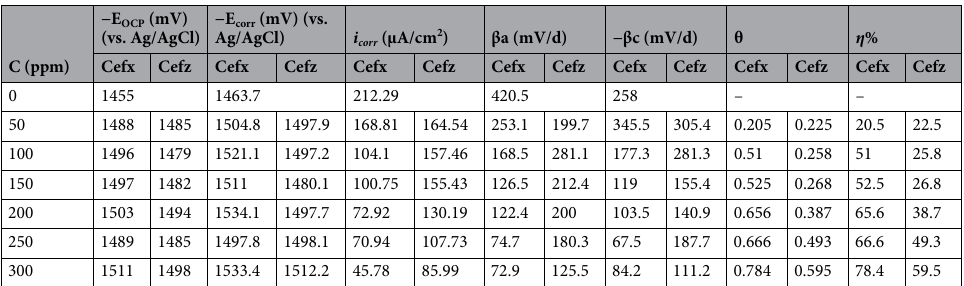
Table 1. Electrochemical kinetic parameters and the inhibition efficiencies of Al in 0.1 M NaOH solution in the absence and presence of different concentrations of Cefx and Cefz drugs at 293 K.